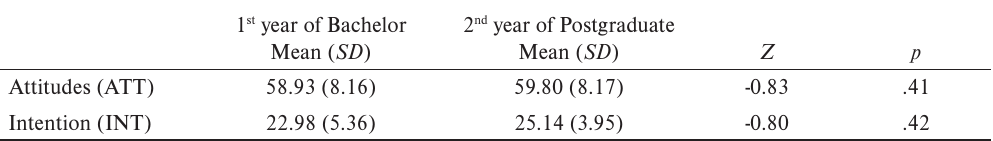
Attitudes towards inclusion of 1 st year of Bachelor and 2 nd year of Postgraduate students